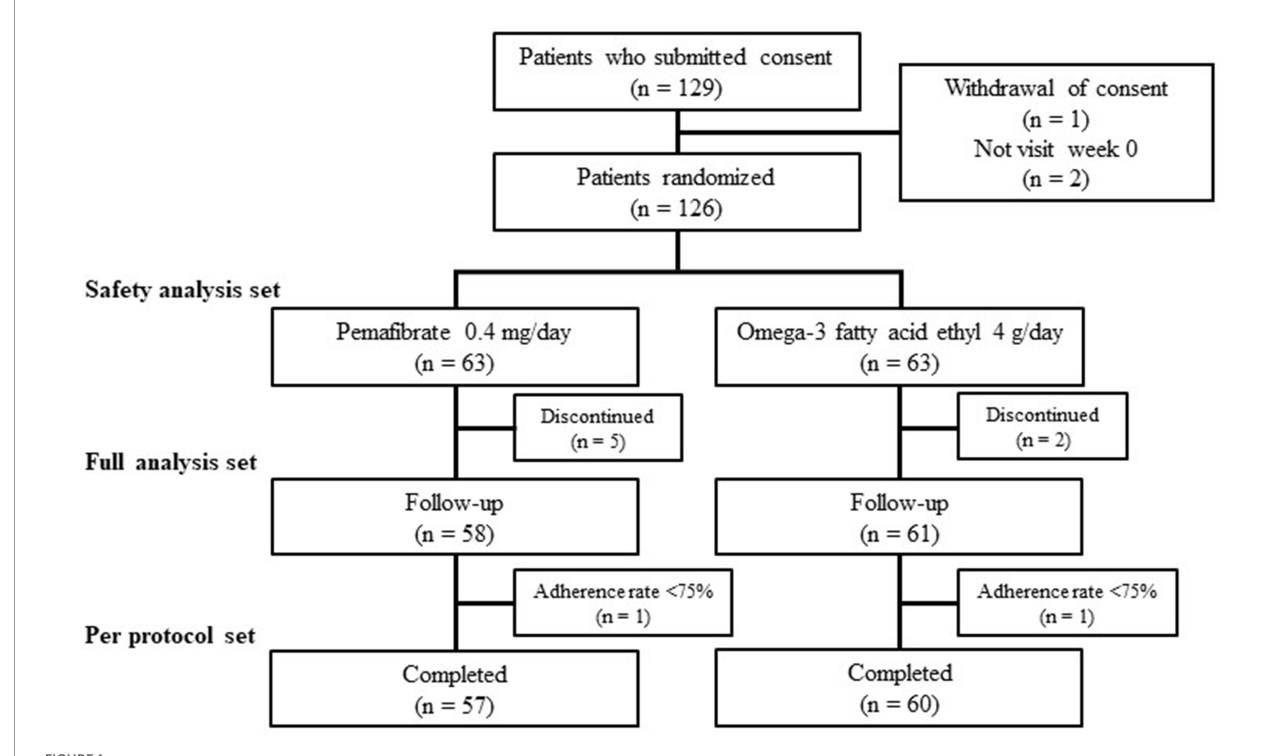
FIGURE1 Flow chart of participant recruitment.